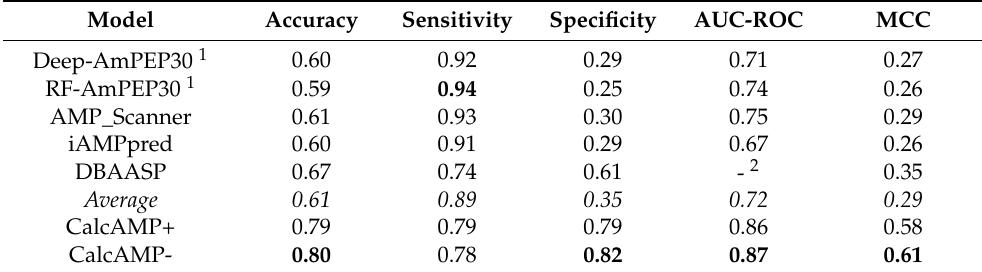
indicate the best value per